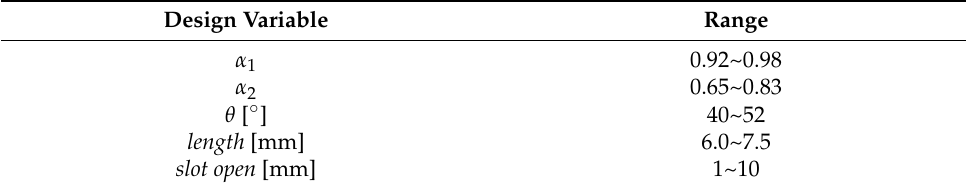
Table 3. Range of design